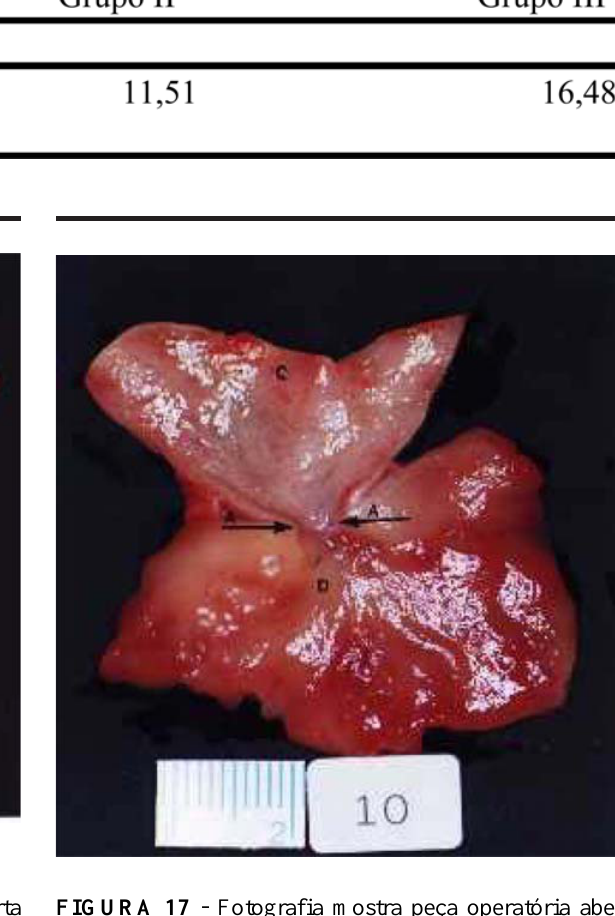
FIGURA 17 - Fotografia mostra peça operatória aberta longitudinalmente. Colédoco dilatado (C), anastomose diminuída (A) e duodeno (D). Suíno 10. Grupo I.